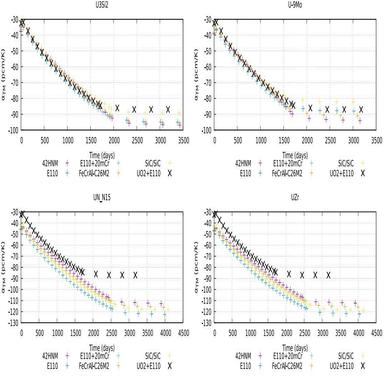
Moderator temperature reactivity feedbacks of chosen fuel-cladding combinations.